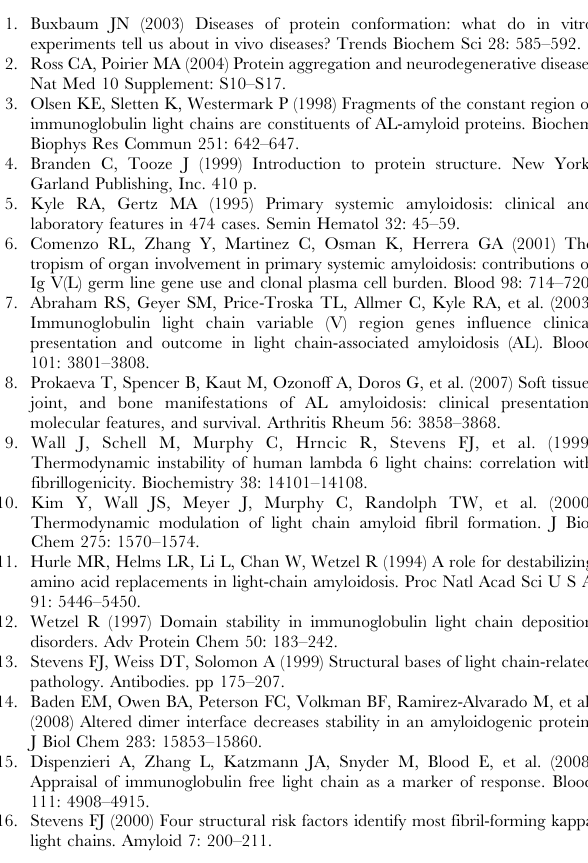
Figure S10 The total mutations were counted for each AL patient and the fraction of those that were considered non- conservative graphed. The majority of the AL Lambda patients had a fraction of non-conservative mutations falling between 0.6 and 0.79, whether they were Lambda I, II and III or Lambda VI. The majority of AL Kappa patients had a fraction of non- conservative mutations falling between 0.4 and 0.59. Found at: doi:10.1371/journal.pone.0005169.s010 (0.78 MB TIF) Figure S11 Comparison of the number of non-conservative mutations over total number of individuals between Multiple Myeloma, normal kappas and normal lambdas (Data from Figure 3). Found at: doi:10.1371/journal.pone.0005169.s011 (0.47 MB